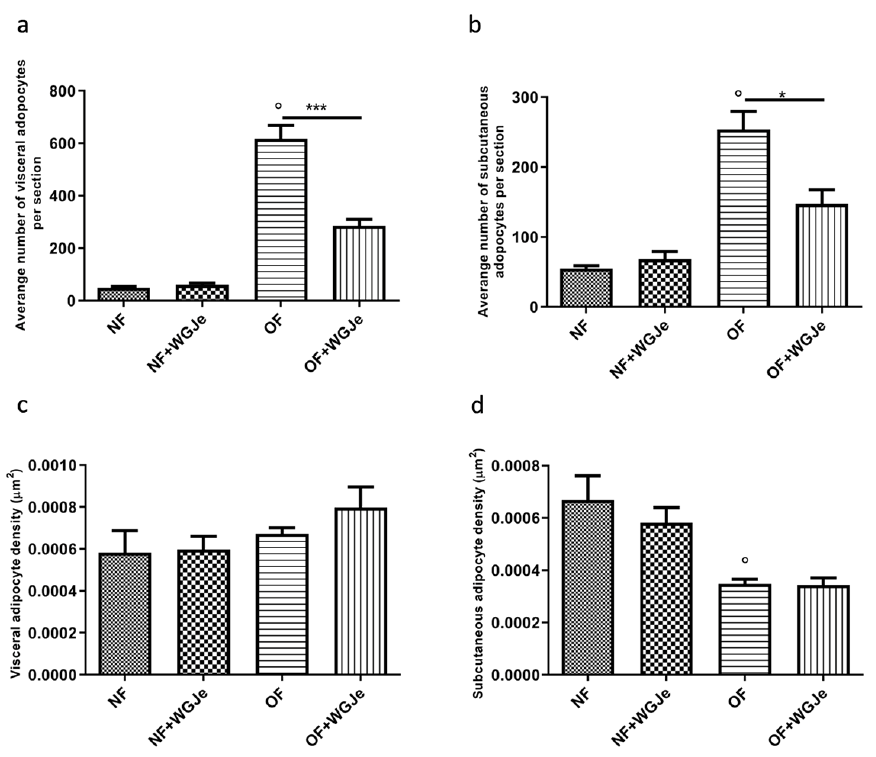
Figure 5. Variation of adipocyte cell number and density in WGJe-treated and untreated NF and OF zebrafish. The morphometric analysis of visceral ( a ) and subcutaneous ( b ) adipose tissue displayed a significant reduction of the number of adipocytes ( a , b ) in the OF + WGJe group compared to the OF untreated group. The adipocyte density was not statistically reduced at either visceral ( c ) or subcutaneous ( d ) levels. Values reported in the density graphs are expressed in µm 2 of adipose tissue per section and represent the mean ± SD of 10 animals per group. * p < 0.05, *** p < 0.001 vs. respective counterparts; ° p < 0.001 vs. NF.